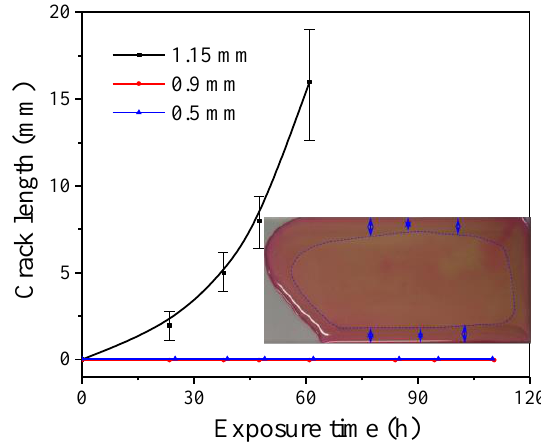
Figure 15. Interface crack growth for samples with different epoxy coating thickness. (Inset shows the top-view of a delaminated epoxy coating/steel substrate sample).